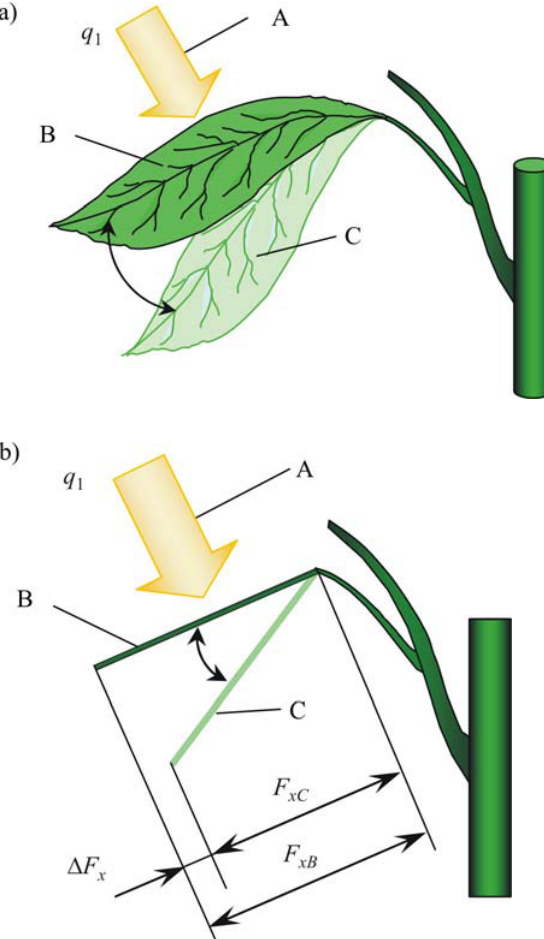
Fig. 1. Chart of changing plant leaf position with respect to the Sun’s radiation: A – solar radiation direction; B, C – edge positions of the plant leaf with respect to the Sun; a – plant leaf position changing scheme; b – changes of plant leaf surface projection to the plane perpendicular to ray fall